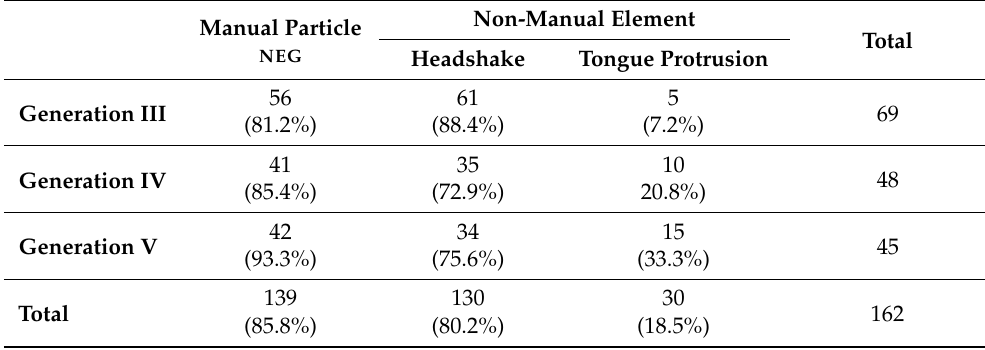
Table 2. Absolute and relative frequency of manual and non-manual markers used in standard negation. 7